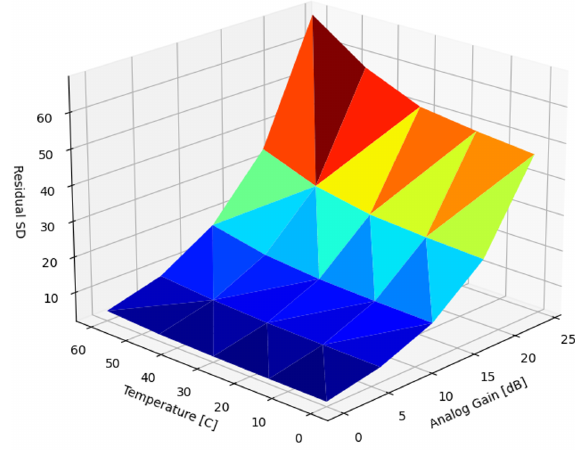
Figure 9. Standard deviation of uncorrected DSNU.